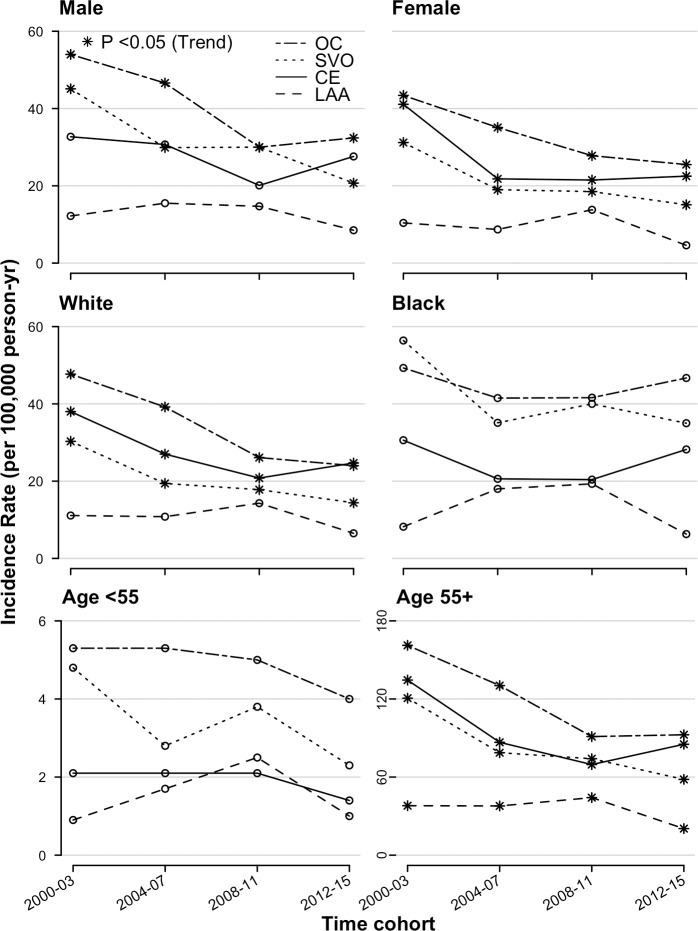
Trends in the age-standardised† annual incidence per 100,000 per year for first-ever ISs by sex, ethnicity, and age.† To the 2011 population of England and Wales. p-Values were obtained from the Cochran-Armitage tests for trend. * denotes significant trends (p < 0.05). CE, cardio-embolism; IS, ischaemic stroke; LAA, large-artery atherosclerosis; OC, other causes; SVO, small-vessel occlusion.